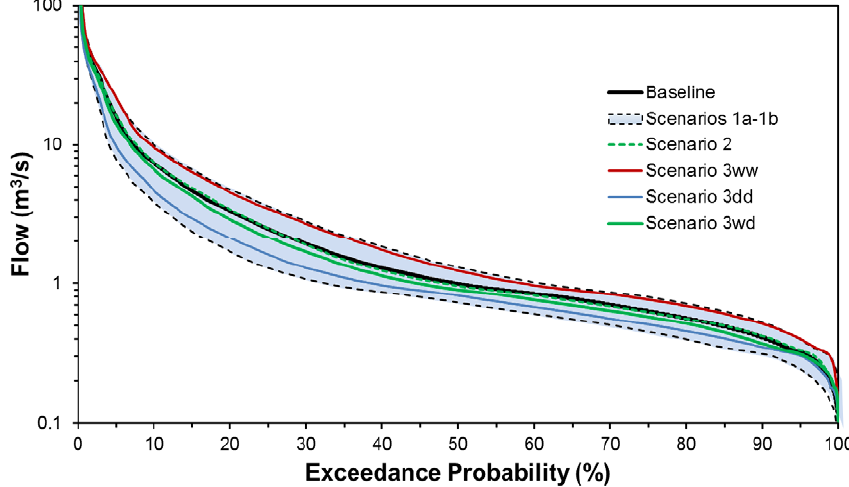
Figure 5. The streamflow exceedance probability curve for the Baseline and six future mid-21st century climate scenarios. climate